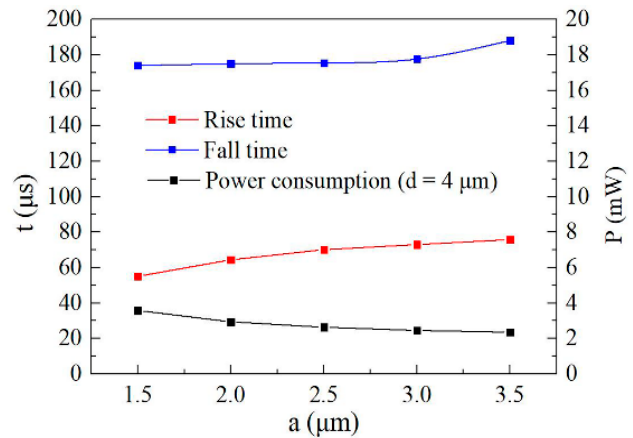
Figure 8. Calculated response time and the power consumption as a function of the electrode width = 4 µ m). ( d = 4 μ m). ( d